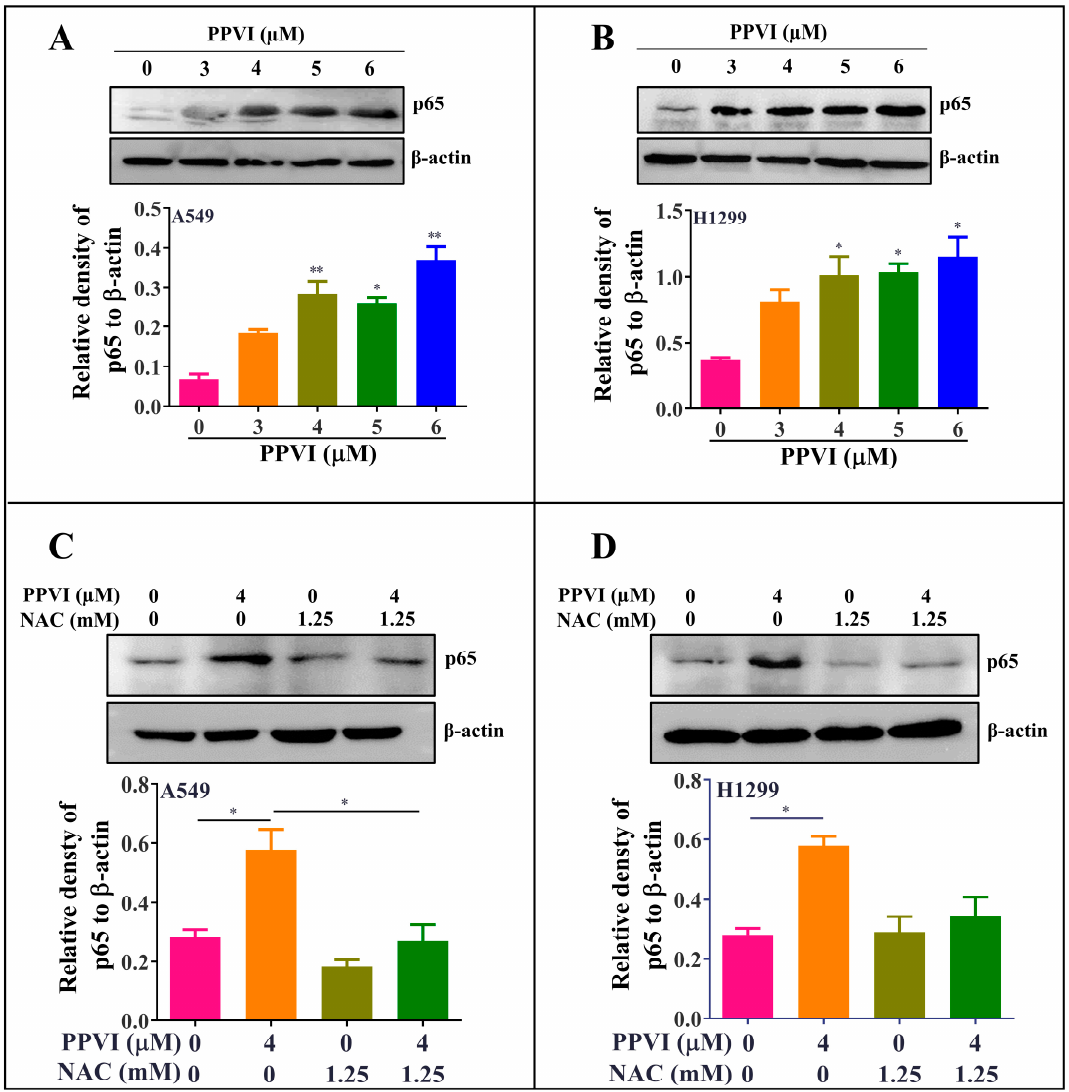
Figure 8. PPVI activated the ROS/NF- к B pathway in A549 and H1299 cells. A549 cells ( A ) and H1299 cells ( B ) were treated with PPVI as indicated by the graded concentrations for 24 h. A549 cells ( C ) and H1299 cells ( D ) were treated with PPVI or co-treated with NAC and PPVI, as indicated by the concentration shown, for 24 h. After treatment, cell protein was then harvested to detect p65 and β -actin by Western blot. Bar chart indicates the relative density of p65 to β -actin; bars, S.D. p ≤ 0.05; * p ≤ 0.01. The full-length Western blotting images are shown in Figure S6.